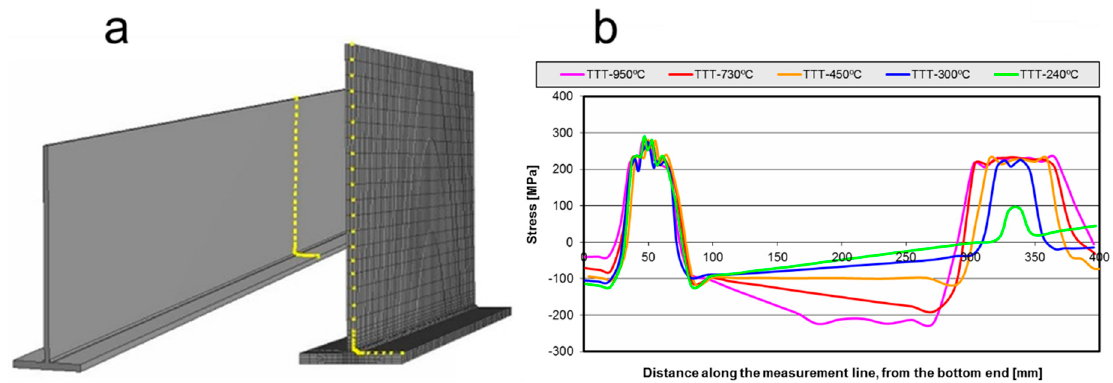
Figure 6. ( a ) Measurement points for the residual stresses; ( b ) Residual stresses over the measurement line for thermal transient tensioning (TTT)-HL283.